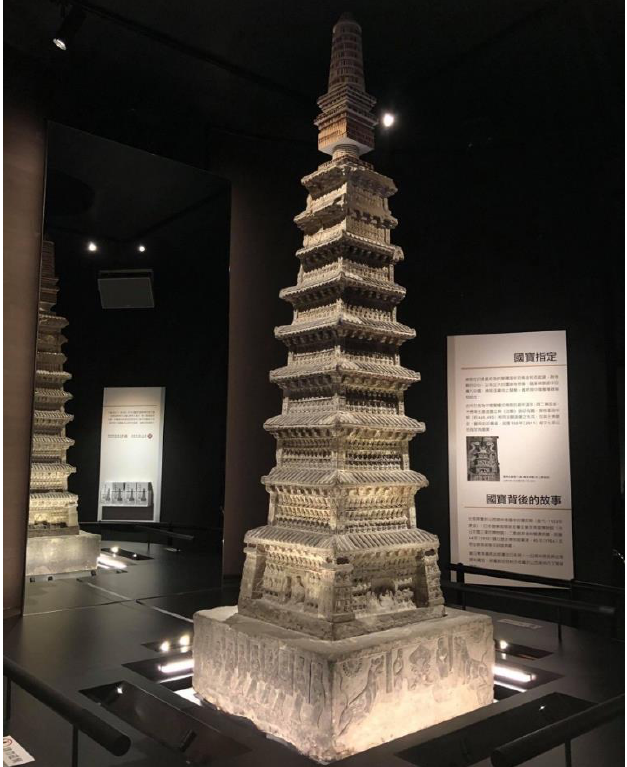
Figure 4. Cao Tiandu 曹天度 Pagoda. Shuozhou, Shanxi Province. 466, Northern Wei. Stone. H. 211.7 cm (with chattra top). National Palace Museum, Taipei ( Chattra preserved in the Chongfu Monastery, Shanxi). Photograph courtesy of Tu Shih-yi.